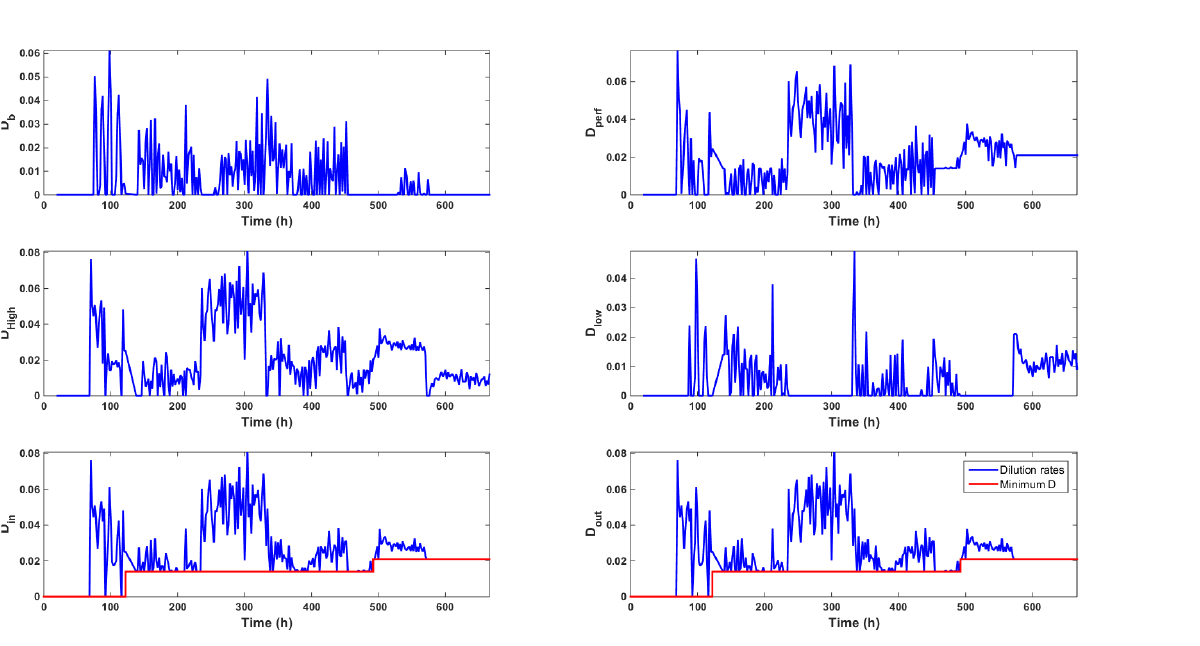
Figure 6. Evolution of the different dilution rates (h − 1 ) computed by the control strategy. These rates are such that D = D in = D low + D High = D b + D perf = D out